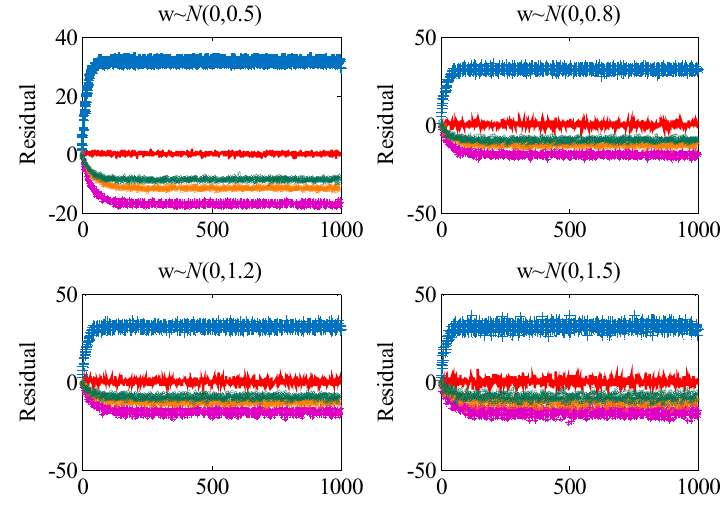
Figure 7. Residual curves under different measurement errors.